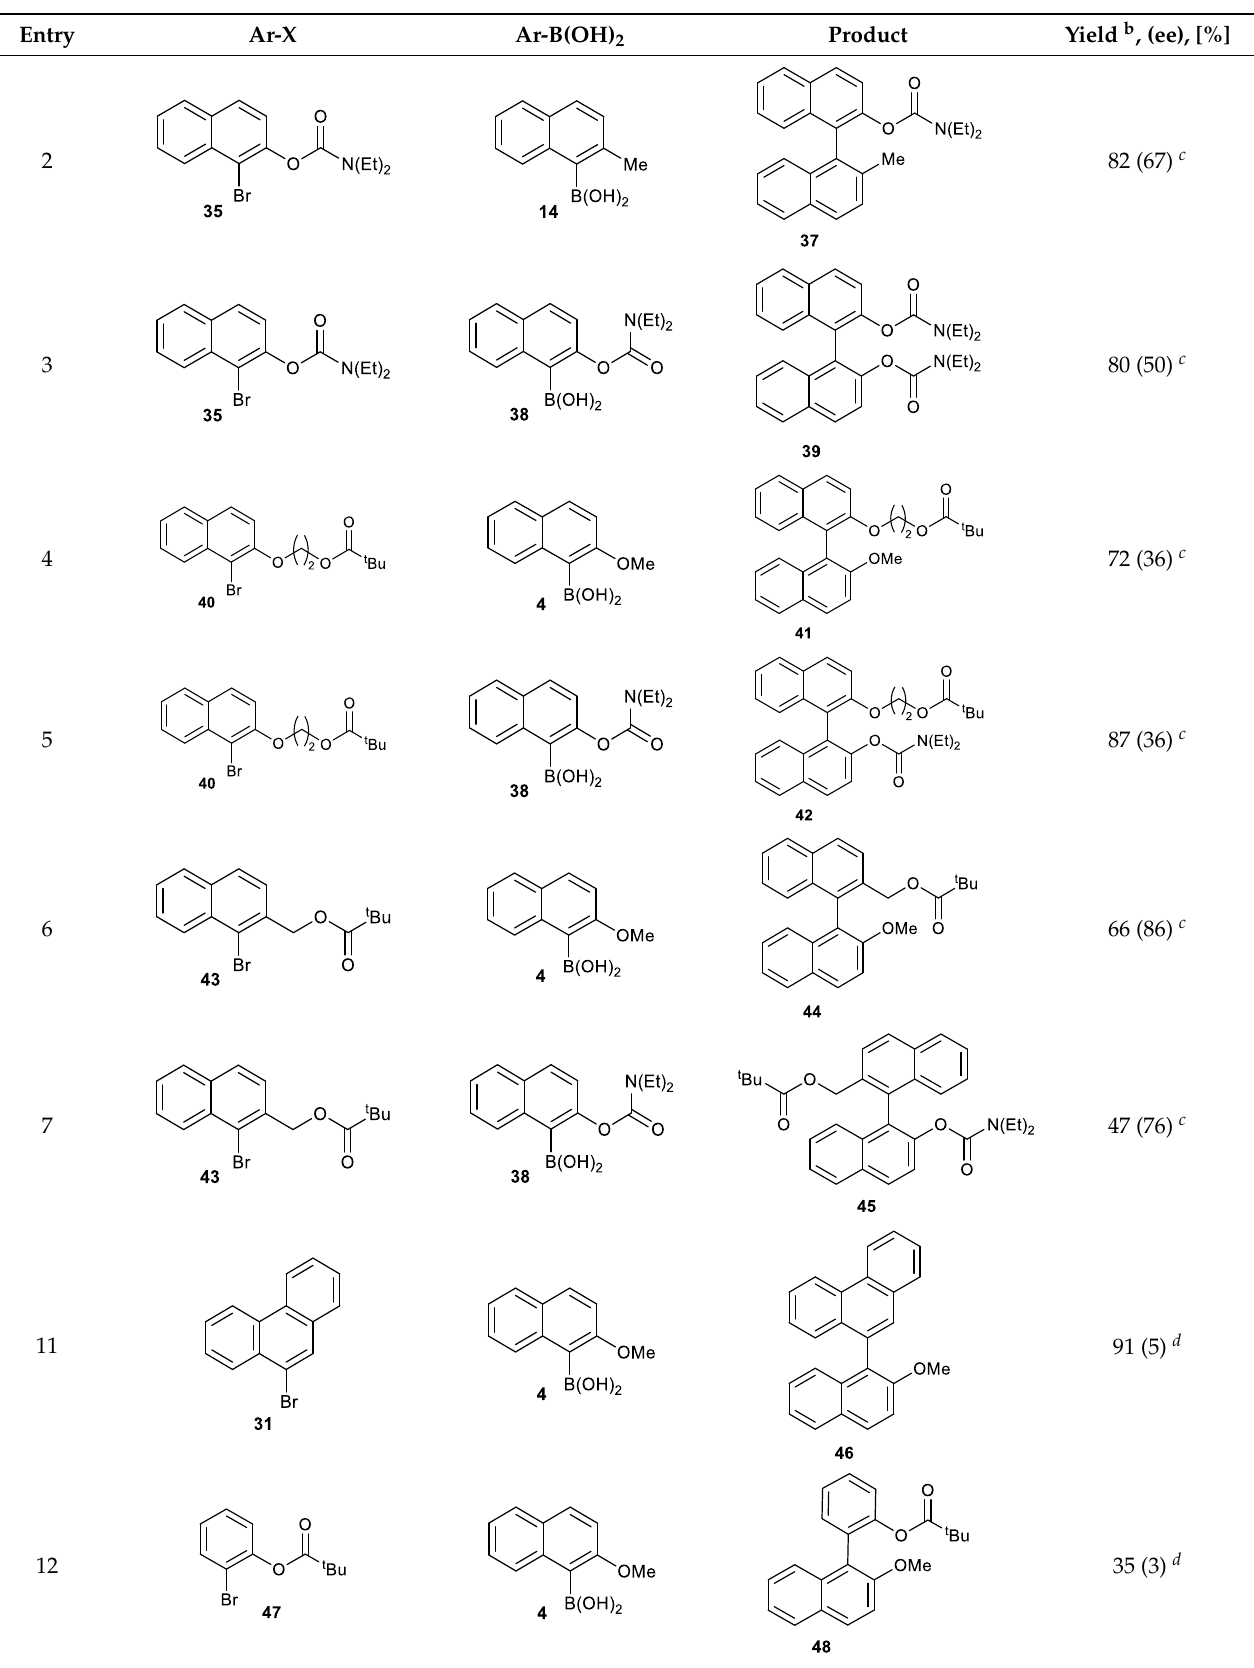
Table 17. Synthesis of biaryls bearing mild-coordinating functional groups a .